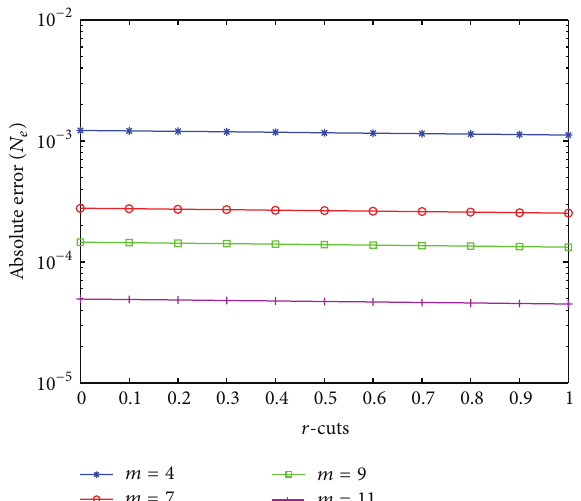
Figure 6: The absolute errors for different values 𝑁 with V = = 0.1386 , and 𝛼 = 𝛽 = 0 , Case 0.85 , 𝑘 2